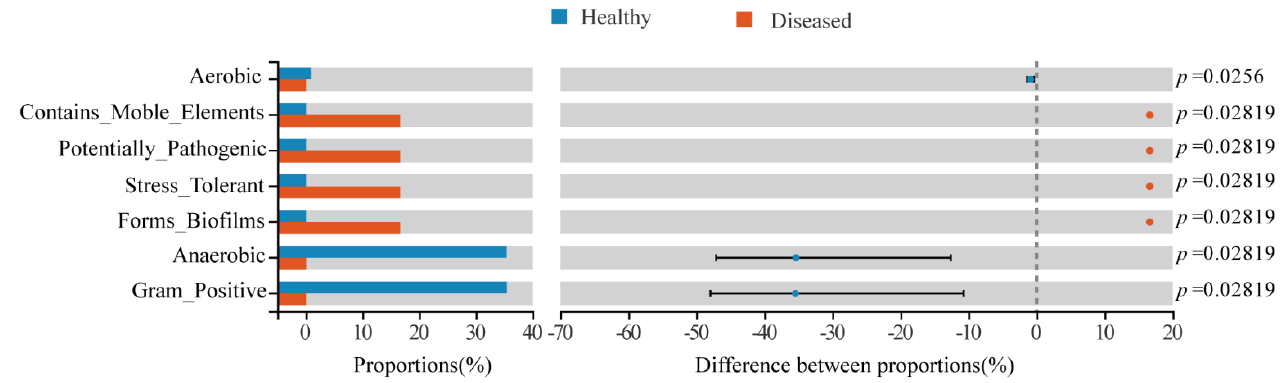
Figure 6. Differences in the predicted phenotypes of the intestinal microbiota between the healthy and diseased fish groups.